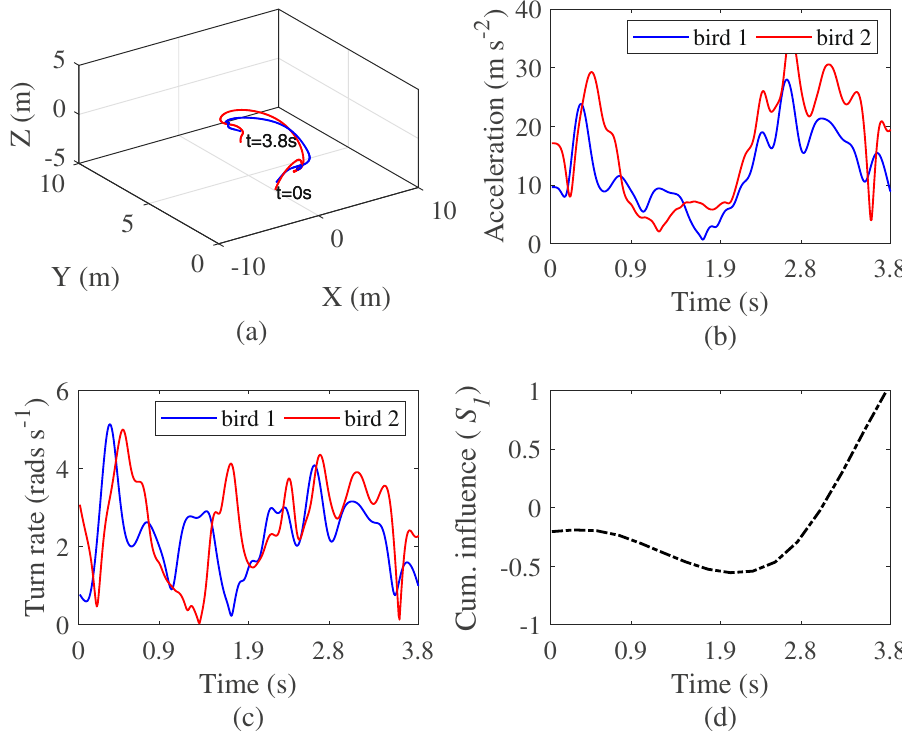
Figure 11. Kinematics of a sample tandem flight with ( a ) birds 3D position, ( b ) acceleration, ( c ) turn rate, and ( d ) time trace of the cumulative information flow from bird 1 to bird 2. Leadership switches from bird 2 to bird 1 about 2.25 s after the beginning of the video recordings. Note that the values of the cumulative influence in (d), are normalized between − 1 and